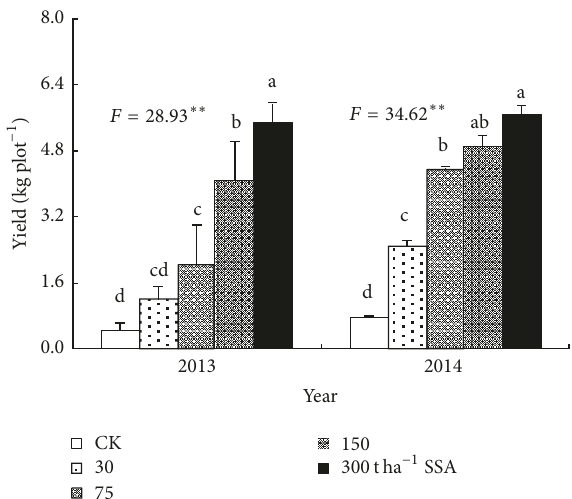
Figure5:Effectsofsewagesludgeamendment(SSA)combinedwith green manuring on yield of maize grown in the mudflat salt-soil. Vertical bars indicate standard deviations of the means. Columns with different letters show significant difference between sewage sludge amendment rates at 𝑝 < 0.05 by LSD’s multiple range test. Values of 𝐹 are the 𝐹 test in ANOVA; ∗∗ 𝑝 < 0.01